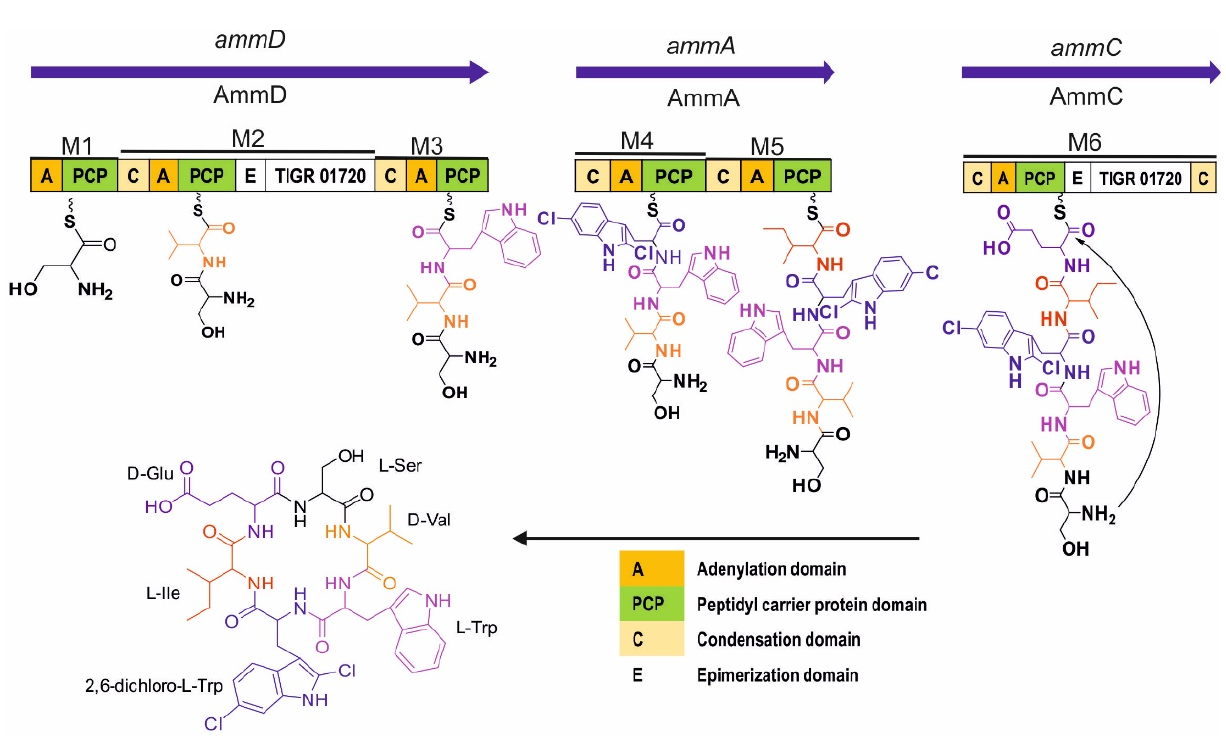
Figure 3. Proposed Biosynthesis of Amycolatomycin A.